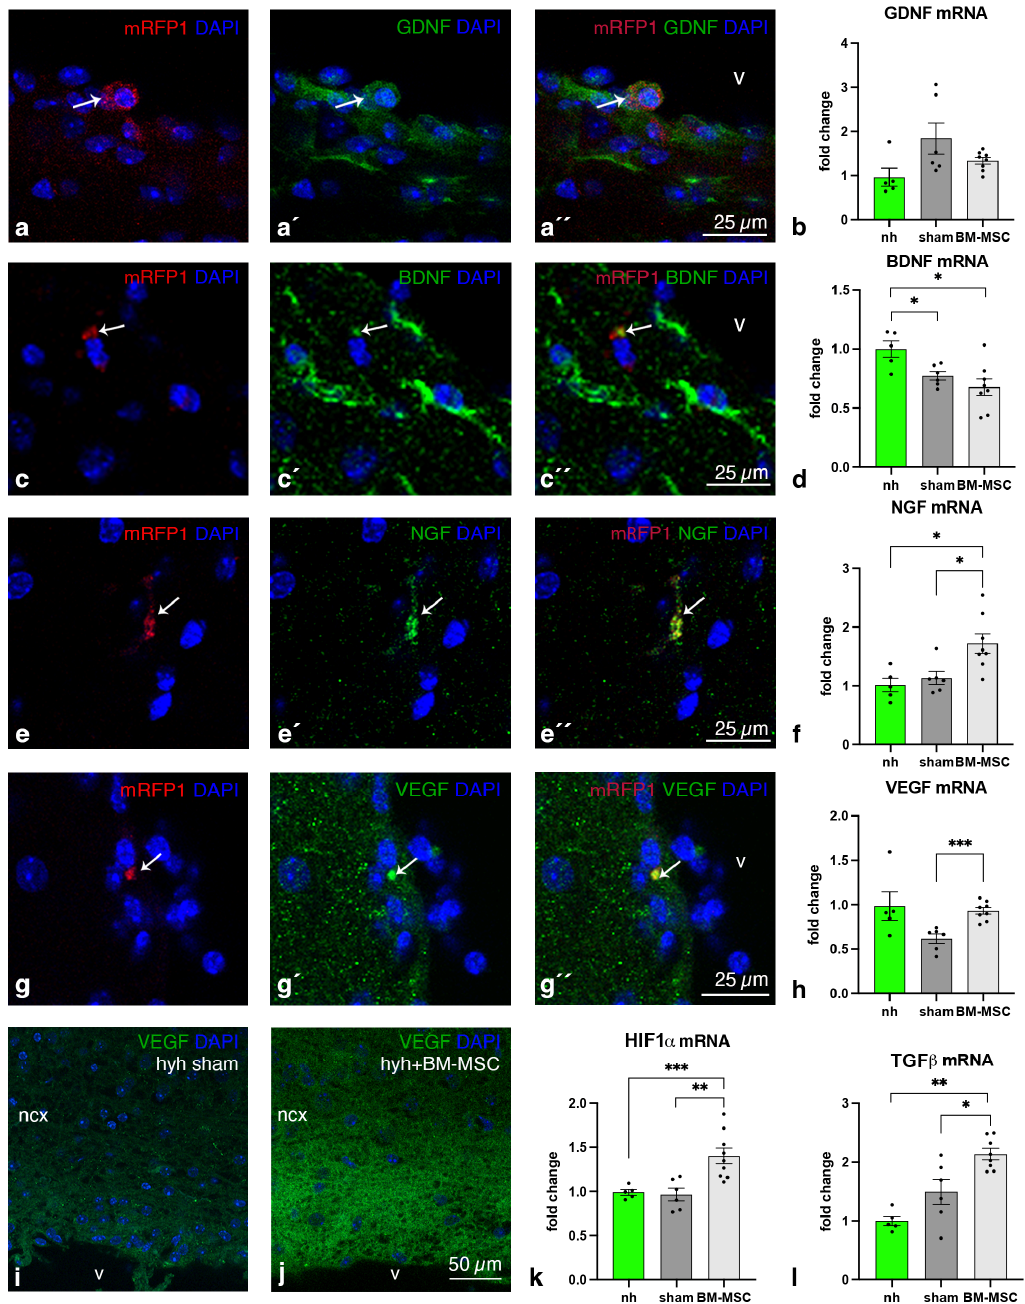
Figure 2. Neuroprotective factors in hydrocephalic hyh mice treated with BM-MSCs. Immunofluo- rescence images detecting ( a,a′ , a″ ) GDNF, ( c , c′ , c″ ) BDNF, ( e , e′ , e″ ) NGF, and ( g , g′ , g″ ) VEGF (green) in BM-MSCs (arrows) in the neocortex (ncx) from a hydrocephalic hyh mouse transplanted with BM-MSCs at P18. Separated and merged channels for fluorescence are shown. Fluorescence of mRFP1 is in red. ( b , d , f , h ) mRNA levels of GDNF, BDNF, NGF, and VEGF in the nonhydrocephalic mice (nh, n = 5), sham-injected hydrocephalic hyh mice (sham, n = 7), and BM-MSC-transplanted (BM-MSC, n = 9) hydrocephalic hyh mice at P18. ( i , j ) Immunofluorescence for VEGF in cerebral sections of the sham-injected and BM-MSC-transplanted hydrocephalic hyh mice. ( k , l ) mRNA levels of HIF1 α and TGF β 1 in the nonhydrocephalic mice (nh, n = 5), sham-injected hydrocephalic hyh mice (sham, n = 6), and BM-MSC-transplanted (BM-MSC, n = 8) hydrocephalic hyh mice at P18. Means ± SEM are shown. * p < 0.05; ** p < 0.02; *** p < 0.01; Wilcoxon–Mann–Whitney test. Nuclear staining in blue with DAPI. Abbreviations: ncx, neocortex; v, lateral ventricle